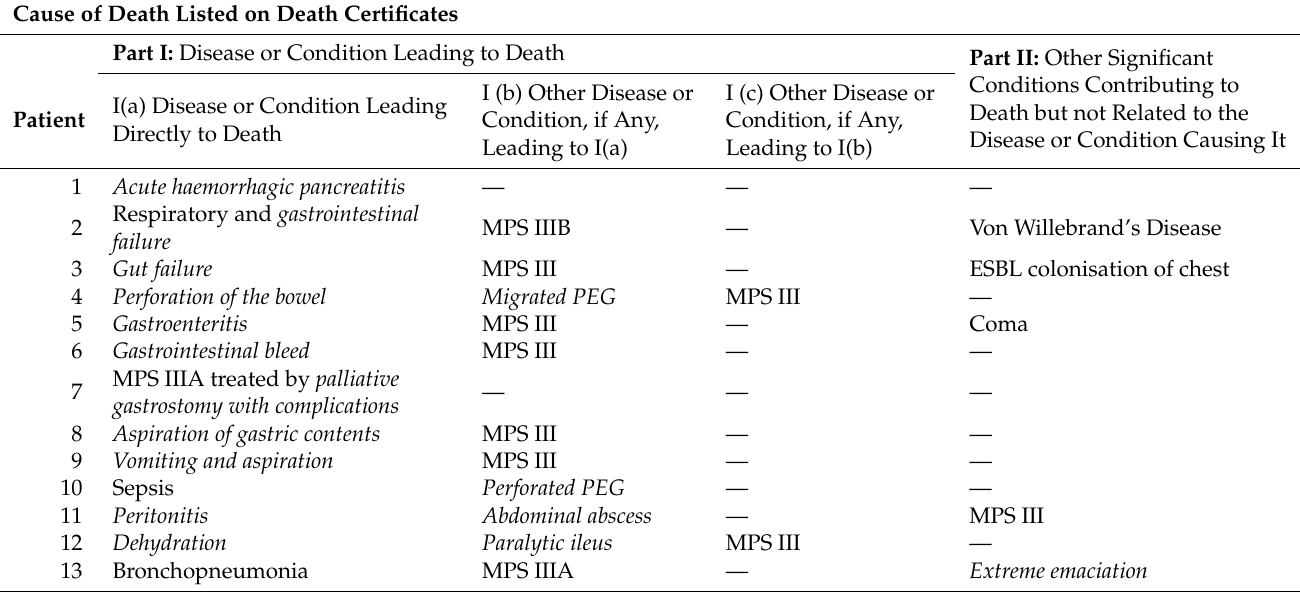
in Table 2. Dates of birth ranged from January 1966 to March 2002, with dates of death between January 1981 to August 2018. Nine deaths (76.9%) occurred during the patient’s second decade of life (i.e., between 10–19 years of age). Two patients died in their third decade of life and one in their fourth (Table 2). Table 3. GI-related conditions ( in italics) leading or contributing to death on death certificates ( n = 13). Causes of death recorded on death certificates follow the Medical Certificate of Cause of Death (MCCD) classification [23].